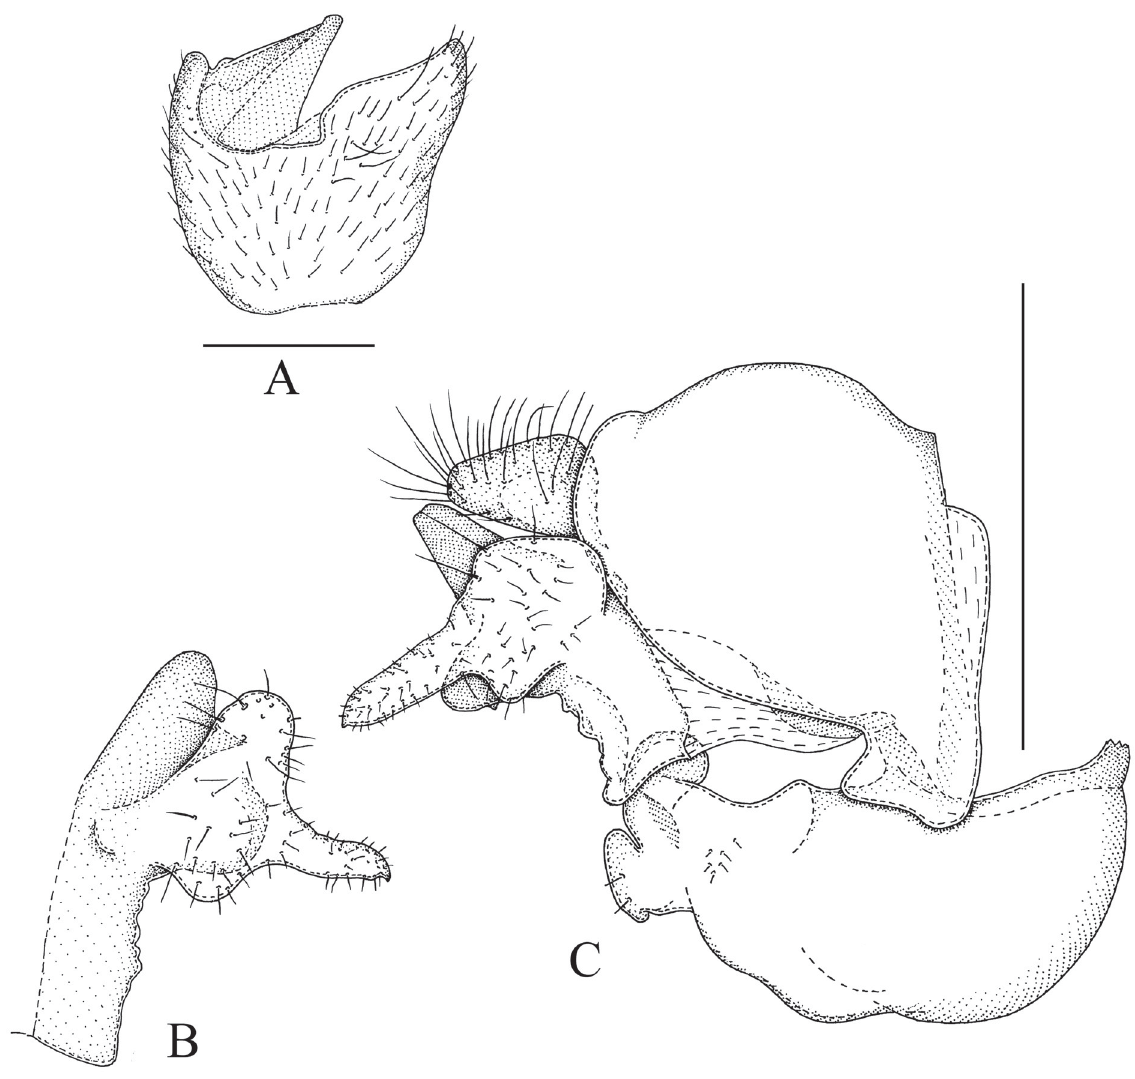
Fig. 73. Sphegina (Asiosphegina) perlobata sp. nov., holot ype, ♂ . A . Sternum IV, ventral view. B . Left surstylus, lateral view. C . Genitalia, right side, lateral view. Scale bars = 0.5